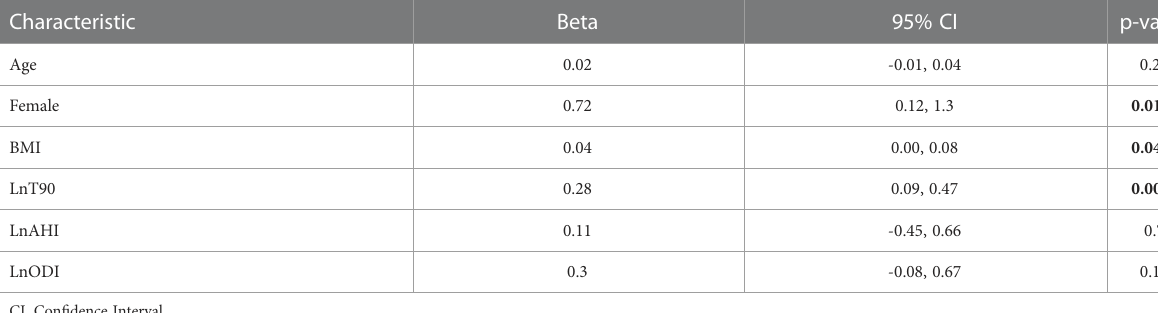
TABLE 2 Univariate